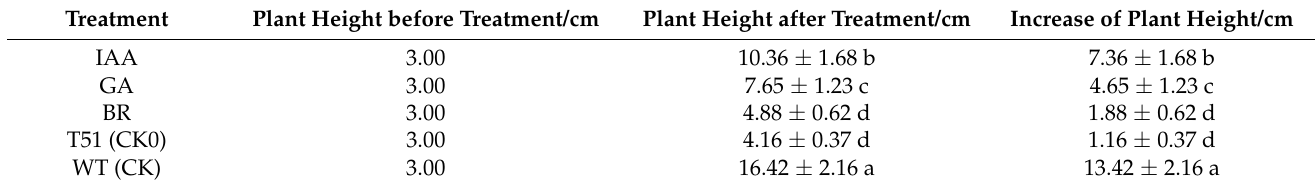
Figure 4. Effect of exogenous hormones on T51 plant height. Note: ( A ). T51 plants sprayed with distilled water; ( B ). T51 plants sprayed with brassinosteroid; ( C ). T51 plants sprayed with Gibberellin; ( D ). T51 plants sprayed with indole-3-acetic acid; ( E ). WT plants sprayed with distilled water. Table 4. Effects of exogenous hormone application on mutant T51 plant height.